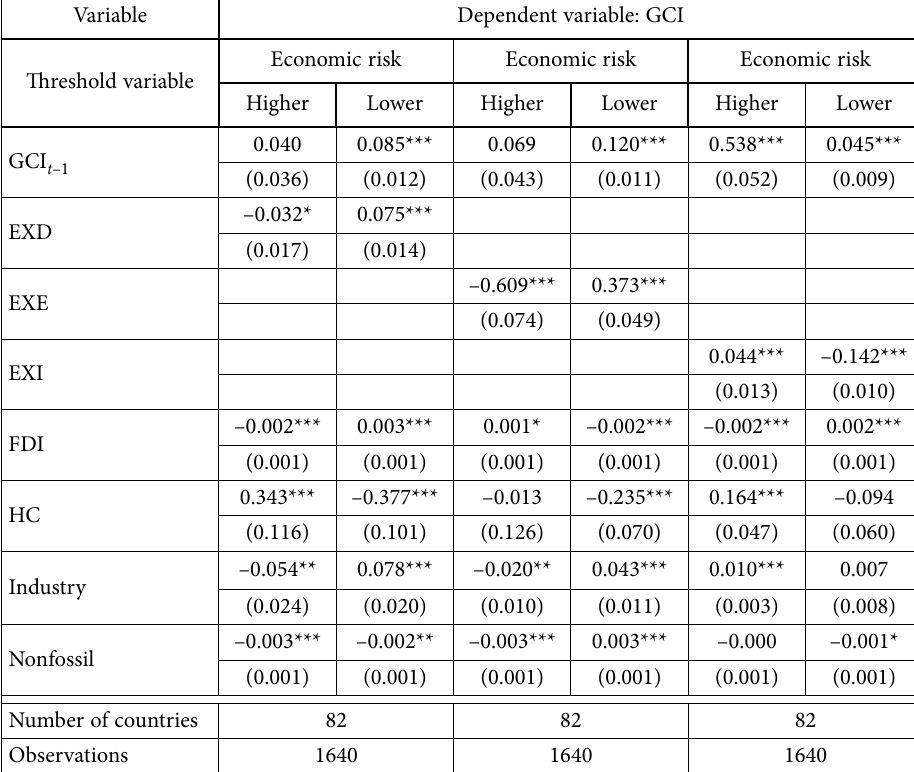
Table 6. DPT estimations for GCI (threshold =